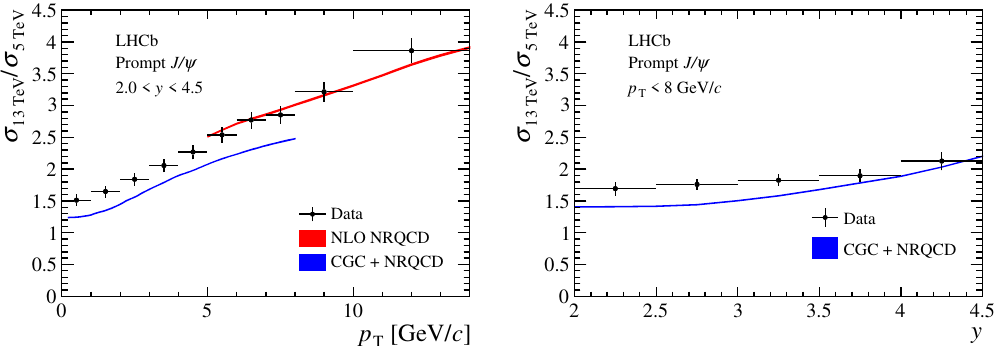
Figure 7 . Ratios of differential cross-sections between 13 TeV and 5 TeV measurements as a function of (left) p T and (right) y for prompt J/ψ mesons compared with NRQCD and CGC calculations [54, 55]. Uncertainties due to the LDMEs determination, renormalisation scales, and factorisation scales are included in the NRQCD and CGC